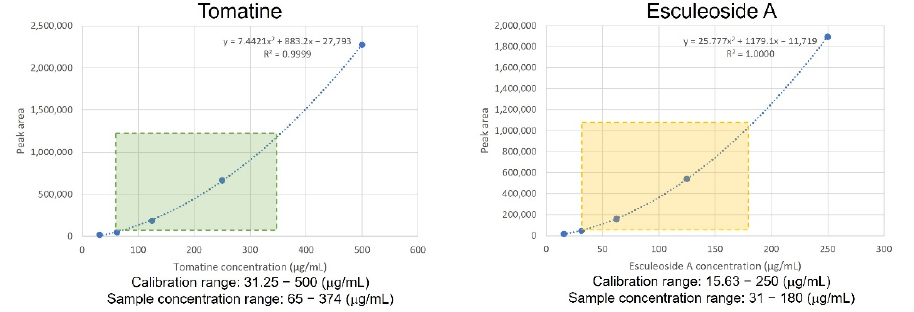
Figure 1. Polynomial-order 2 regression for two steroidal alkaloids identified from the micro-tomato samples. y and x are peak area and concentration of standard solution, respectively. R 2 is coefficient value.